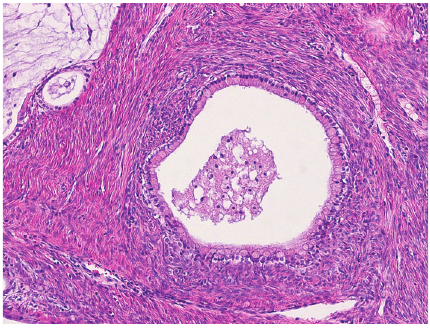
Figure 4: The tumour is composed of glandular and cystic portions lined by mucinous columnar epithelium, with mucinous fluid in the lumen and a predominantly fibromatous stroma ( × 100, H&E